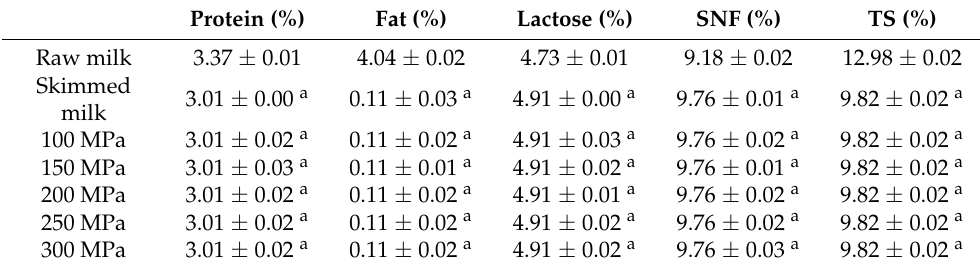
Table 1. The composition of samples.